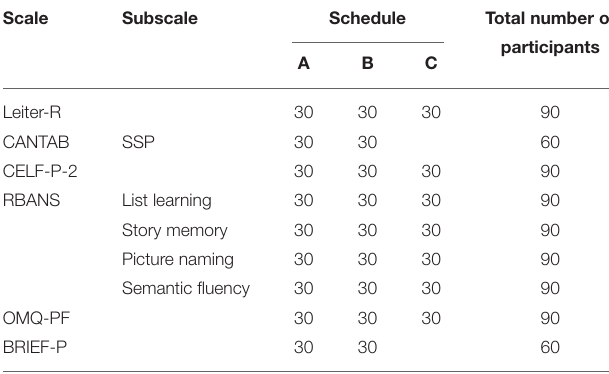
TABLE 1 | Number of participants per randomization schedule and total number of subjects evaluated per